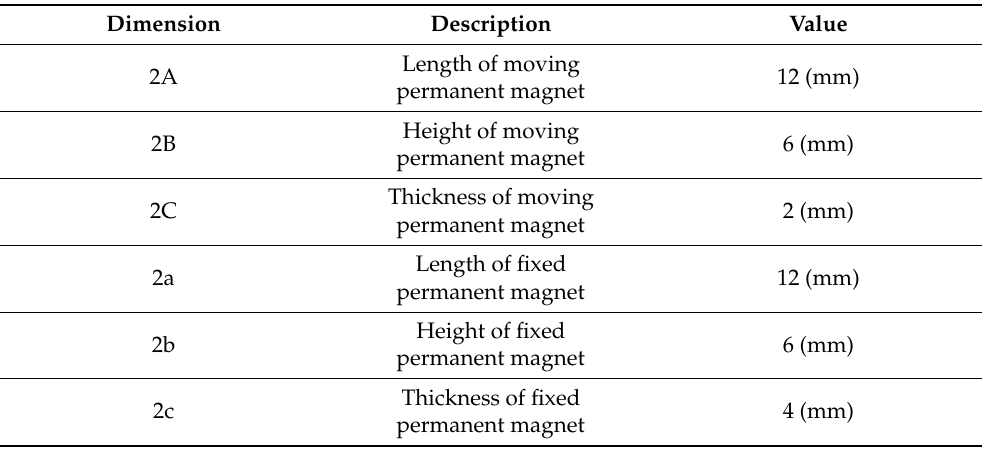
Table 1. Dimensions of permanents magnets used in energy harvester (see Figure